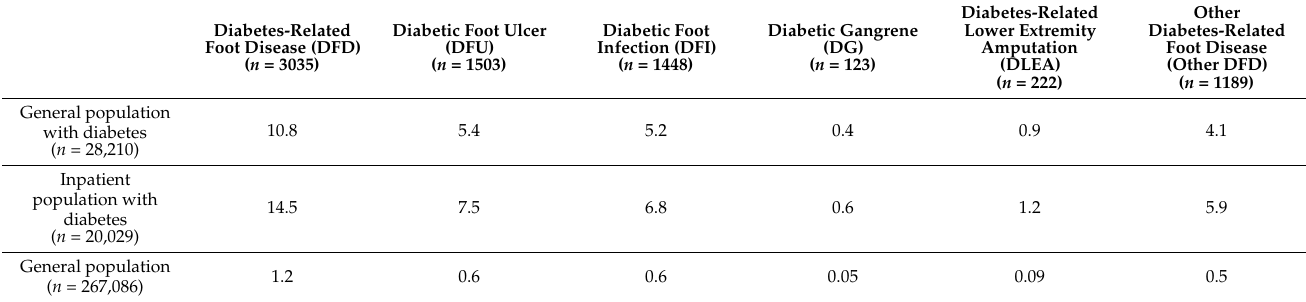
Table A3. Prevalence of DFD, DFU, DFI, DG, DLEA, and other